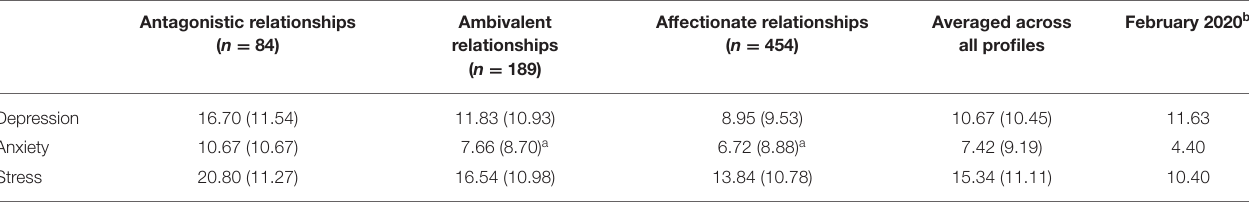
TABLE 5 | Means on DASS-21 for participants in three relationship types and statistics before the COVID-19 pandemic.